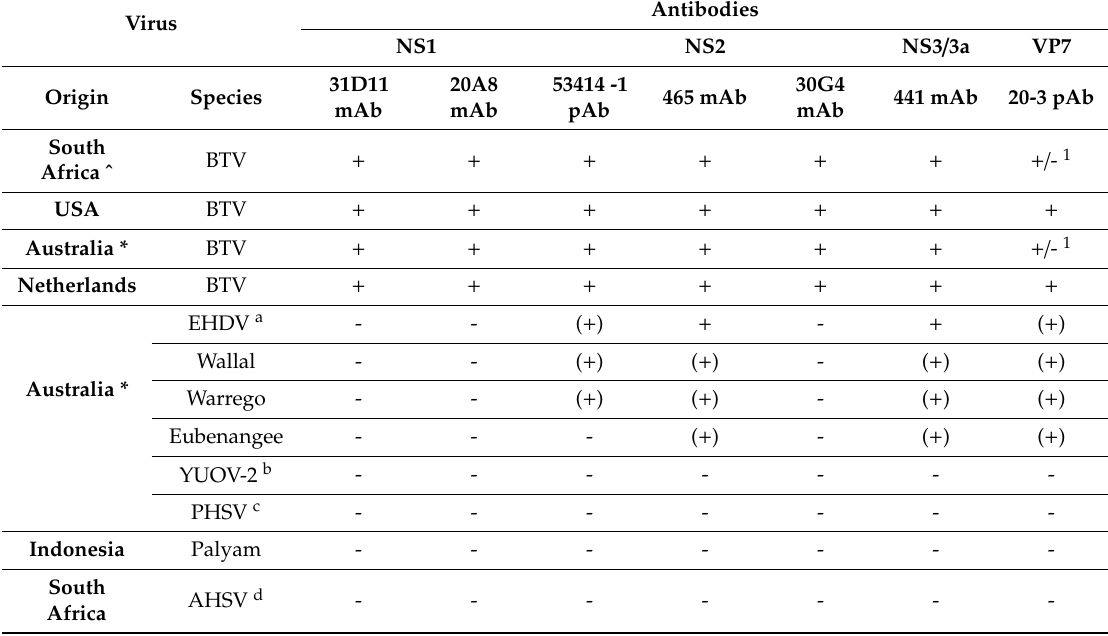
Table 2. Histochemical immunoreactivity of infected baby hamster kidney cells (BHK-BSR) using antibodies against a range of BTV isolates and other orbivirus species from diverse geographic origins. Virus